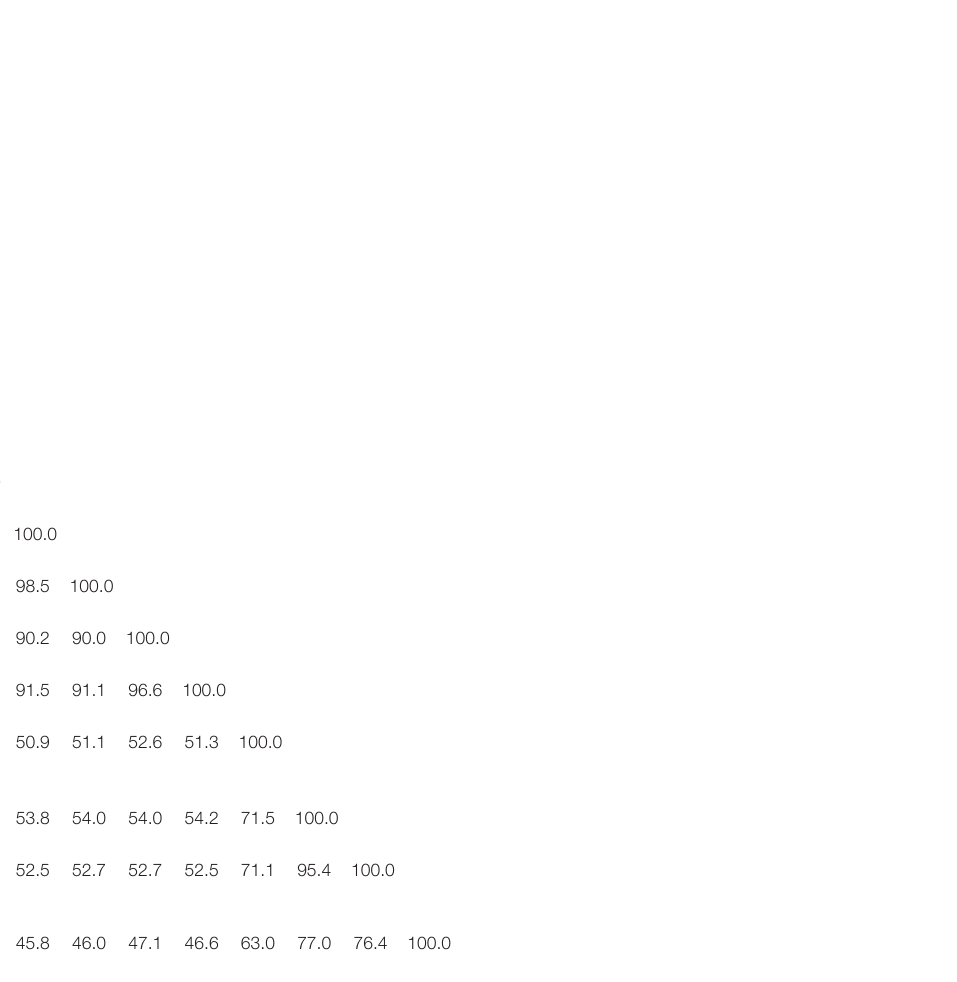
TABLE 4 | Sequence identity matrix showing the amino acid (aa) percent identity of the phocid orthoreovirus 1 to 27 other orthoreoviruses based on the sigma 1 protein (segment S1). Phocid